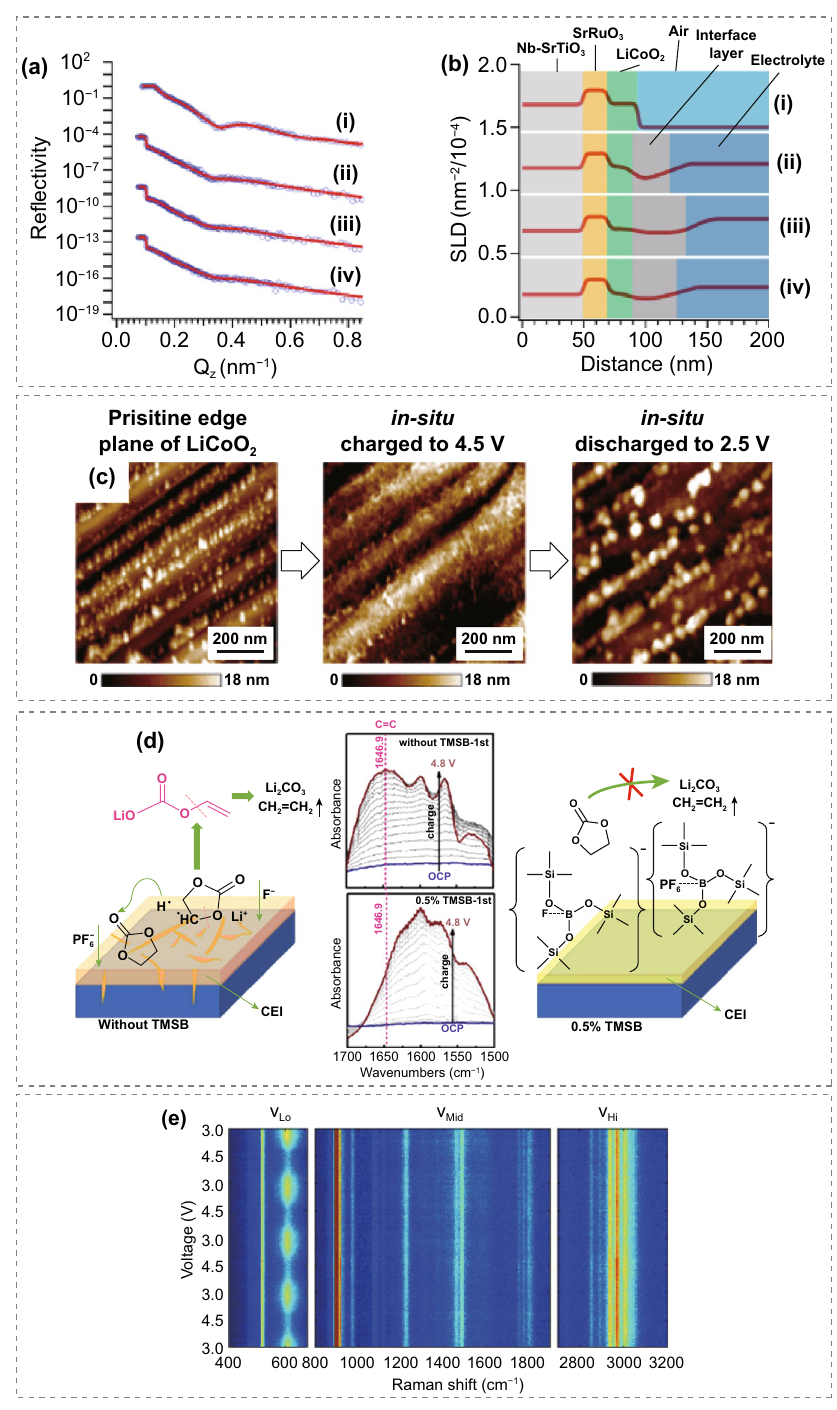
Fig. 3 a Neutron reflectivity and b analyzed scattering length density for samples at different charge states. Copyright from Ref. [57]. c In situ AFM images of the CEI formation and decomposition on the edge of LiCoO 2 crystal Copyright from Ref. [58]. d Operando ATR − FTIR spectra and schematic of CEI formation during the first charging process at the cathode surface in electrolytes with and without tris(trimethylsilyl)- borate additive Copyright from Ref. [59]. e Operando Raman spectral evolution acquired for a LiNi 0.33 Co 0.33 Mn 0.33 O 2 electrode Copyright from Ref.